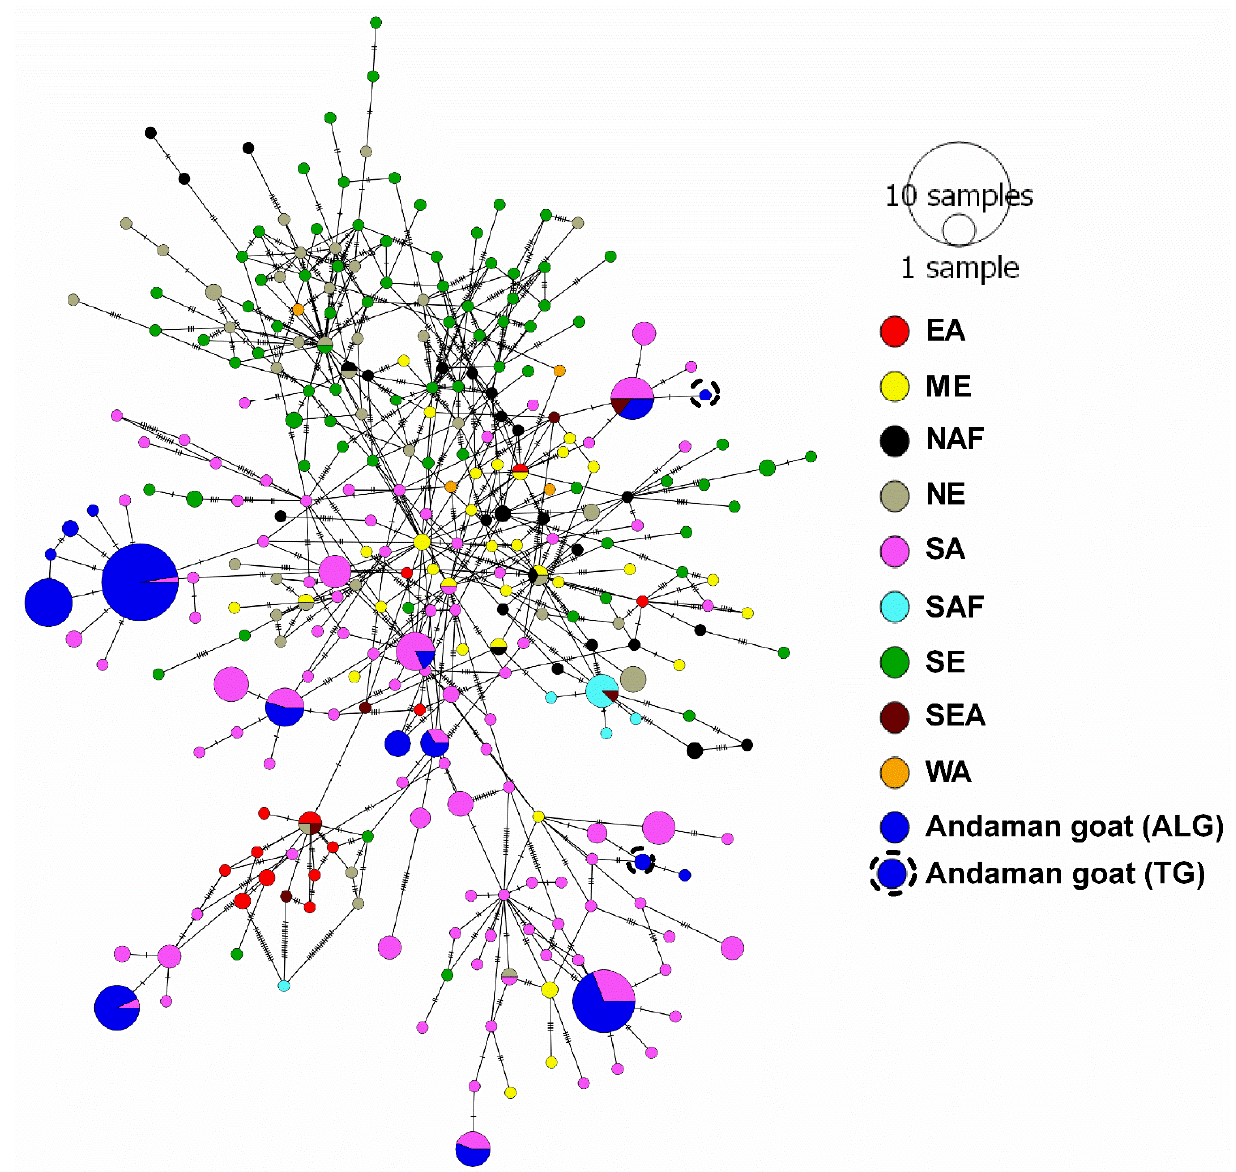
Figure 2. Haplogroup A of Andaman goats and its relationship with A haplogroup goats of different regions. The network was drawn in PopART ver. 1.7 [34]. The map was constructed based on 481 bp hypervariable region (HV1) of mitochondrial D-loop.